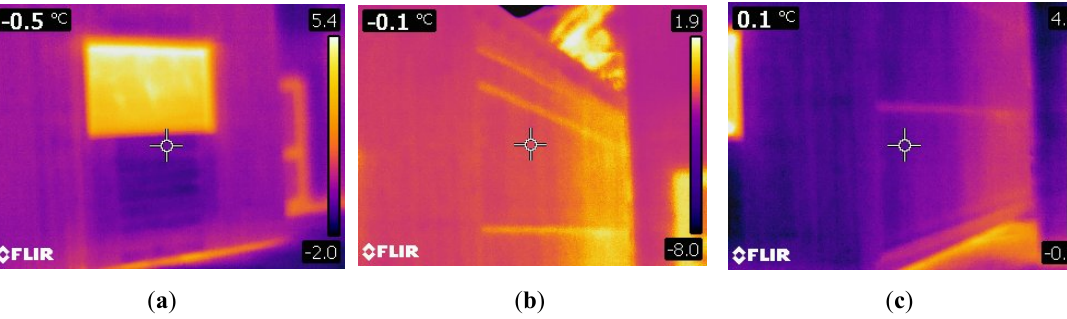
Figure 15. Thermal images of Casa Cembo facades. ( a ) South facade; ( b ) East facade; ( c ) North facade.